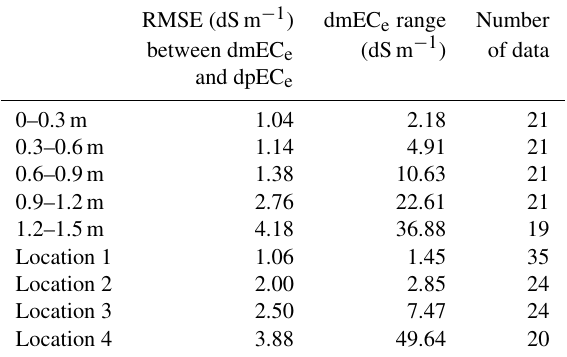
Table 3. RMSE between dmEC e and dpEC e , range of dmEC e , and the number of data used to calculate RMSE, discriminated in terms of depth of measurement and